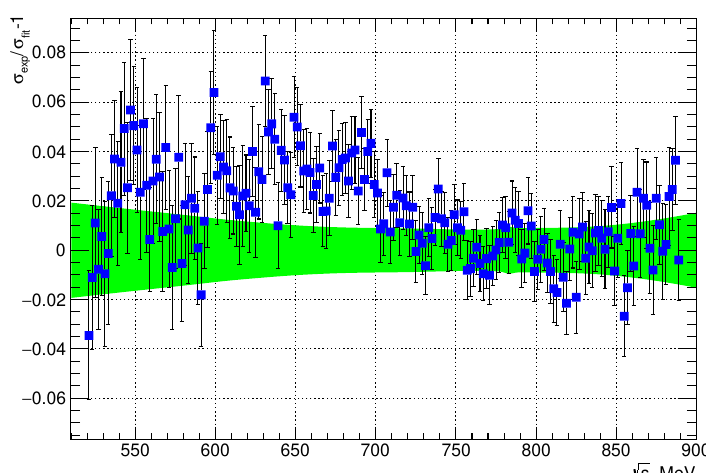
Figure 14 . The relative di(cid:11)erence between the e + e (cid:0) ! (cid:25) + (cid:25) (cid:0) cross section measured by BaBar [32] and the (cid:12)t to the SND data. The error bars take into account both statistic and systematical errors of BaBar data. The shaded area corresponds to the quadratic sum of the systematic and statistical errors of the